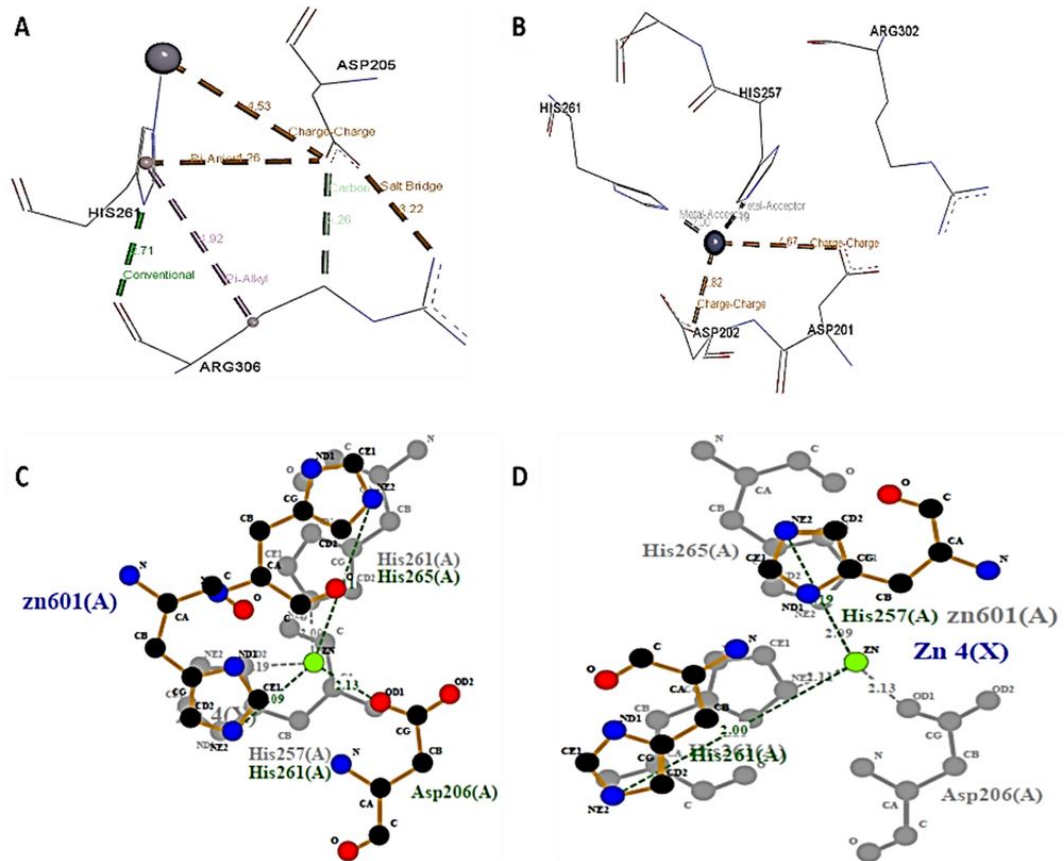
Figure 7. Interactions in the catalytic region around the metal zinc in the 5ZNT protein ( A ) and the Bombyx-Aedes model ( B ) and the overlapping of the amino acid residues closest to the zinc metal in the 5ZNT protein ( C ) and the Bombyx-Aedes model ( D ).